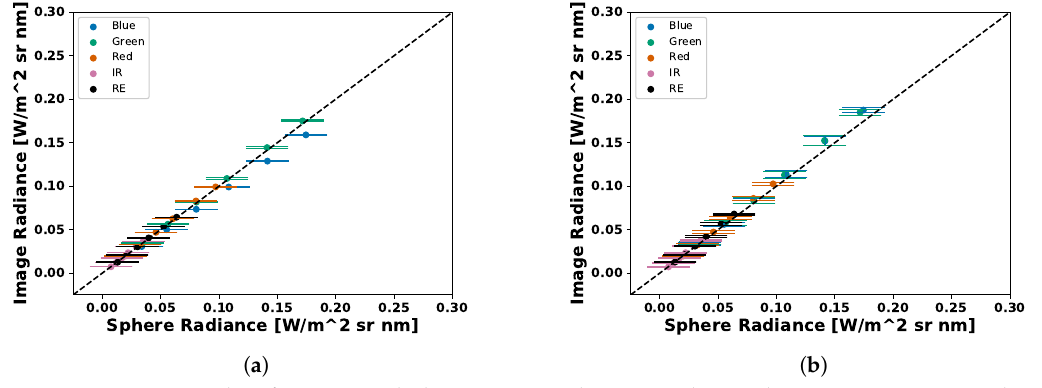
Figure 22. Scatter plot of average RedEdge-M image radiance vs sphere radiance. Images converted to radiance using ( a ) MicaSense methodology ( b ) Average Vignette Proposed methodology. Proposed methodology produces less error as less spread is seen in the scatter